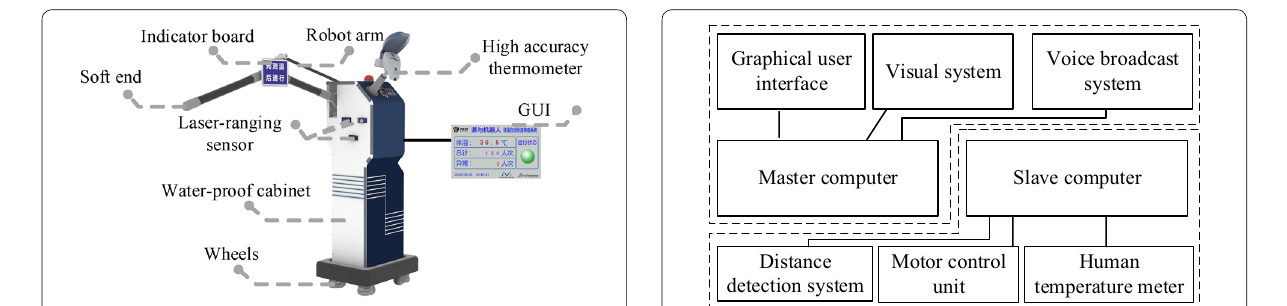
Figure 3 Structure of the SHUYUmini robot